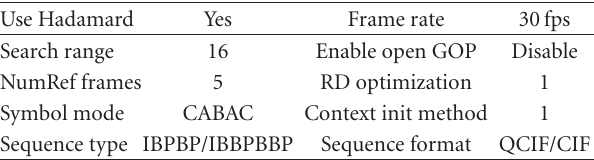
Figure 3: The speed acceleration percentage of standard H.264 encoder with mathematic model. Table 1: Encoder parameters used in the experiments.